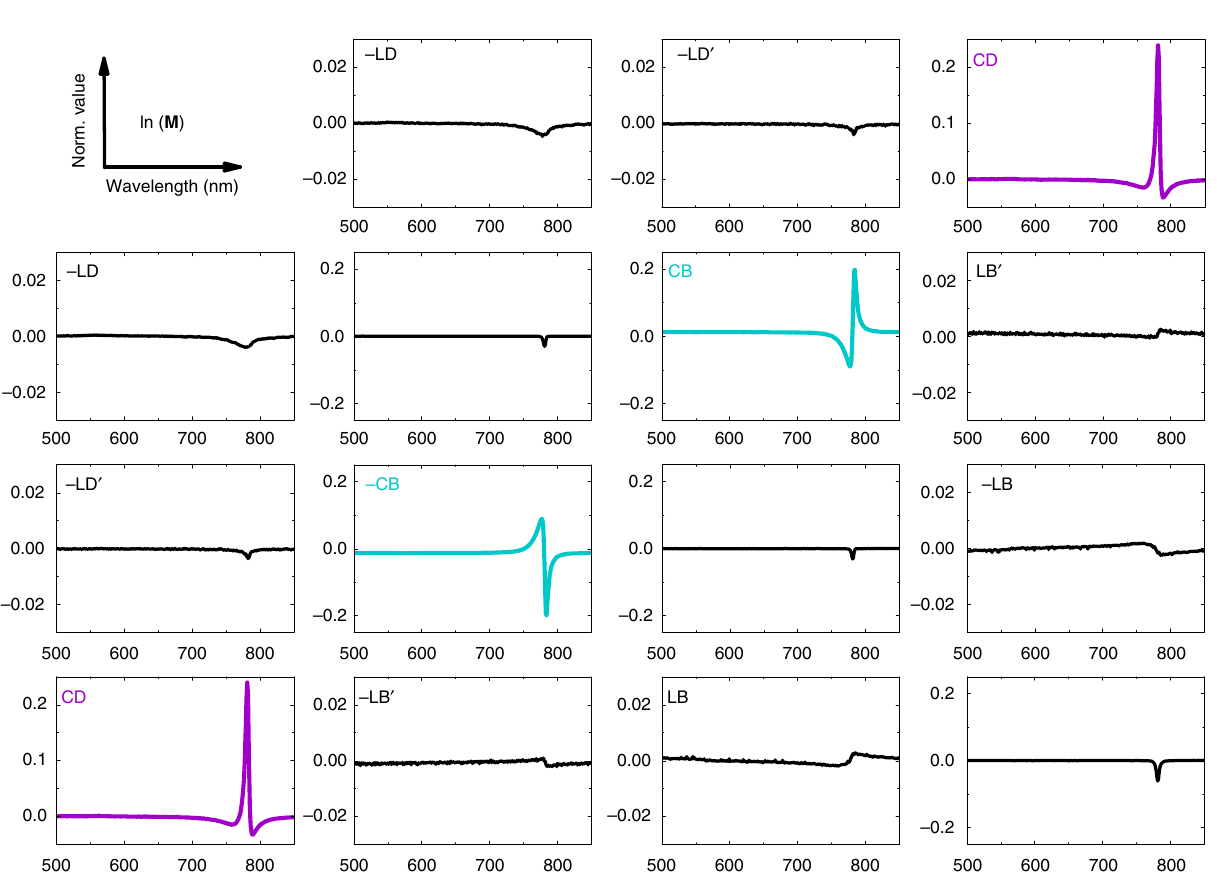
Fig. 4 Mueller matrix spectroscopy. Calculated differential Mueller matrix L of ( R,R )-ProSQ-C16 annealed at 180 °C with 16 nm fi lm thickness. The assignment of the matrix elements is according to Eq. (1) in units of radian vs. wavelength in nm. The element l 00 equals zero and is omitted. Note that the scaling of the axes for the linear anisotropies is smaller by a factor of